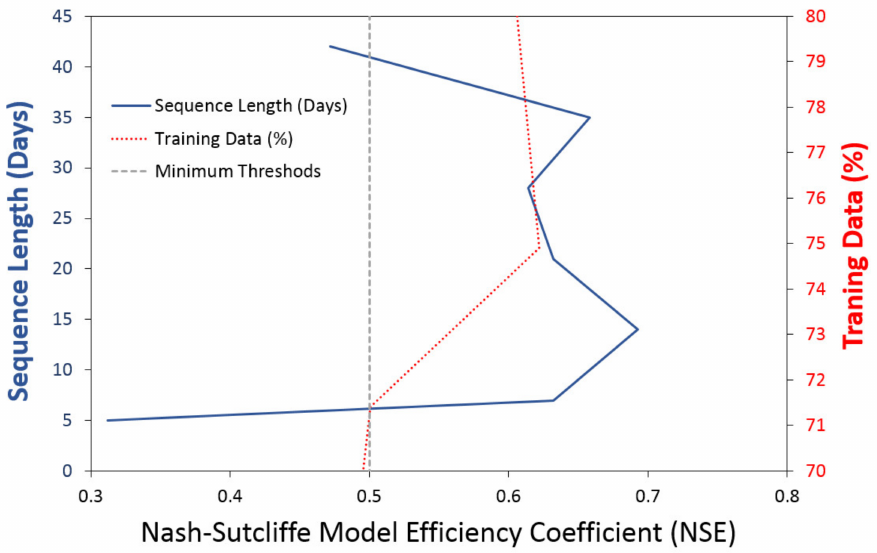
Figure 11. Minimum threshold according to conditions sequence length and training